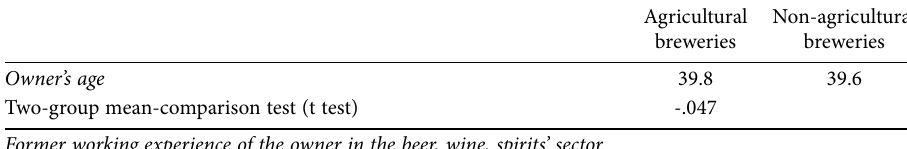
Table 5. Structural characteristics: comparison between survey responses of agricultural and non-agri- cultural breweries (% of